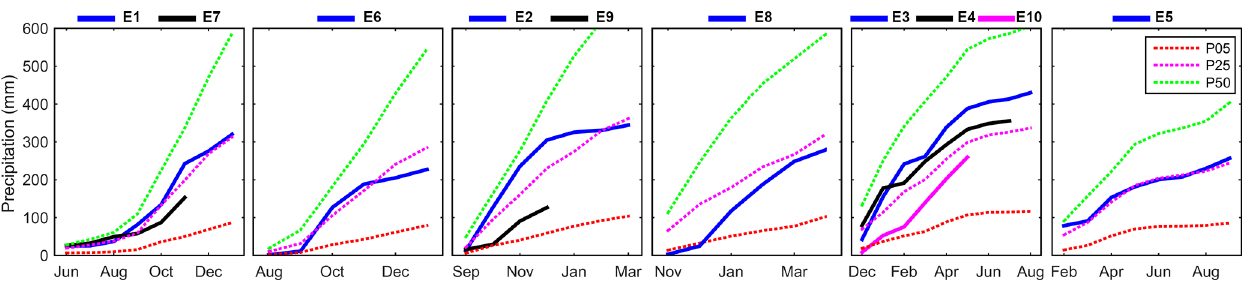
Figure 6. Accumulated precipitation during each drought episode listed in Table 3 (solid lines) and the monthly accumulated per- centiles 5 (P05), 25 (P25), and 50 (P50) of precipitation (discontinued lines) while considering the whole study period (1980–2017). Table 3. The 10 most severe drought episodes that affected the MLSHD from 1980 to 2017 arranged based on their severity from highest to lowest. The onset (first month of the episode), peak (lowest SPEI1 value during the episode), termination (last month of the episode), and duration (number of months from the onset to the termination) are shown. Episode Onset Peak End Peak Duration Severity value (months)